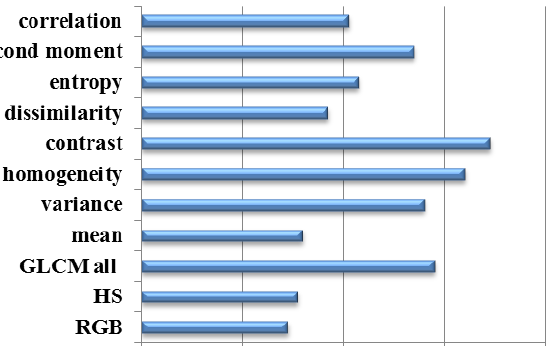
Figure 4. Silhouette value for analysing the feature signficance in differentiating the image regions with